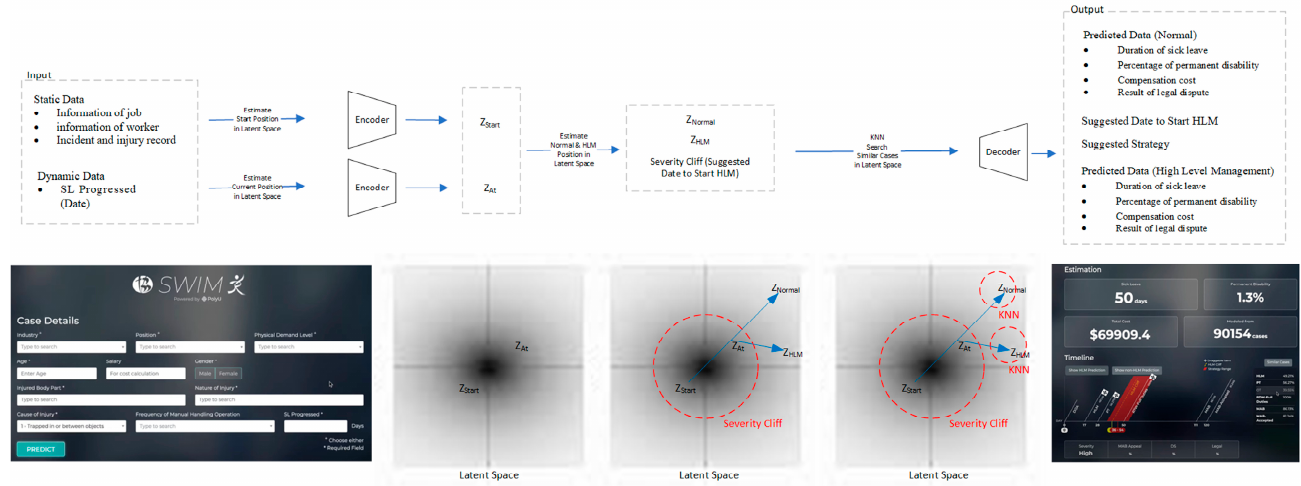
Figure 2. Overview of the machine learning and latent space concept in SWIM 1.0.